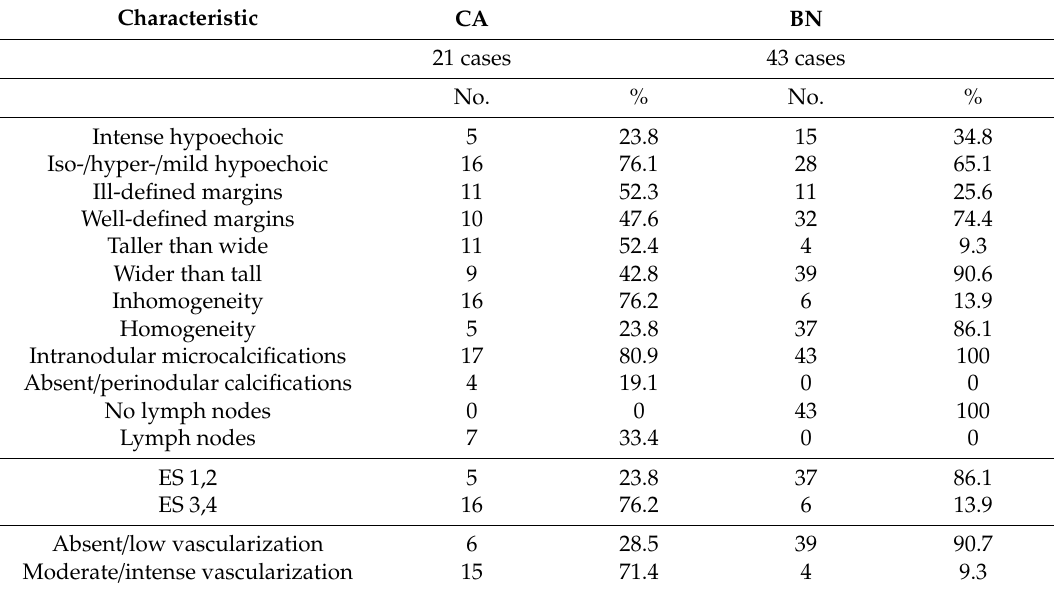
Table 1. Ultrasound characteristics in each nodule (64 cases).